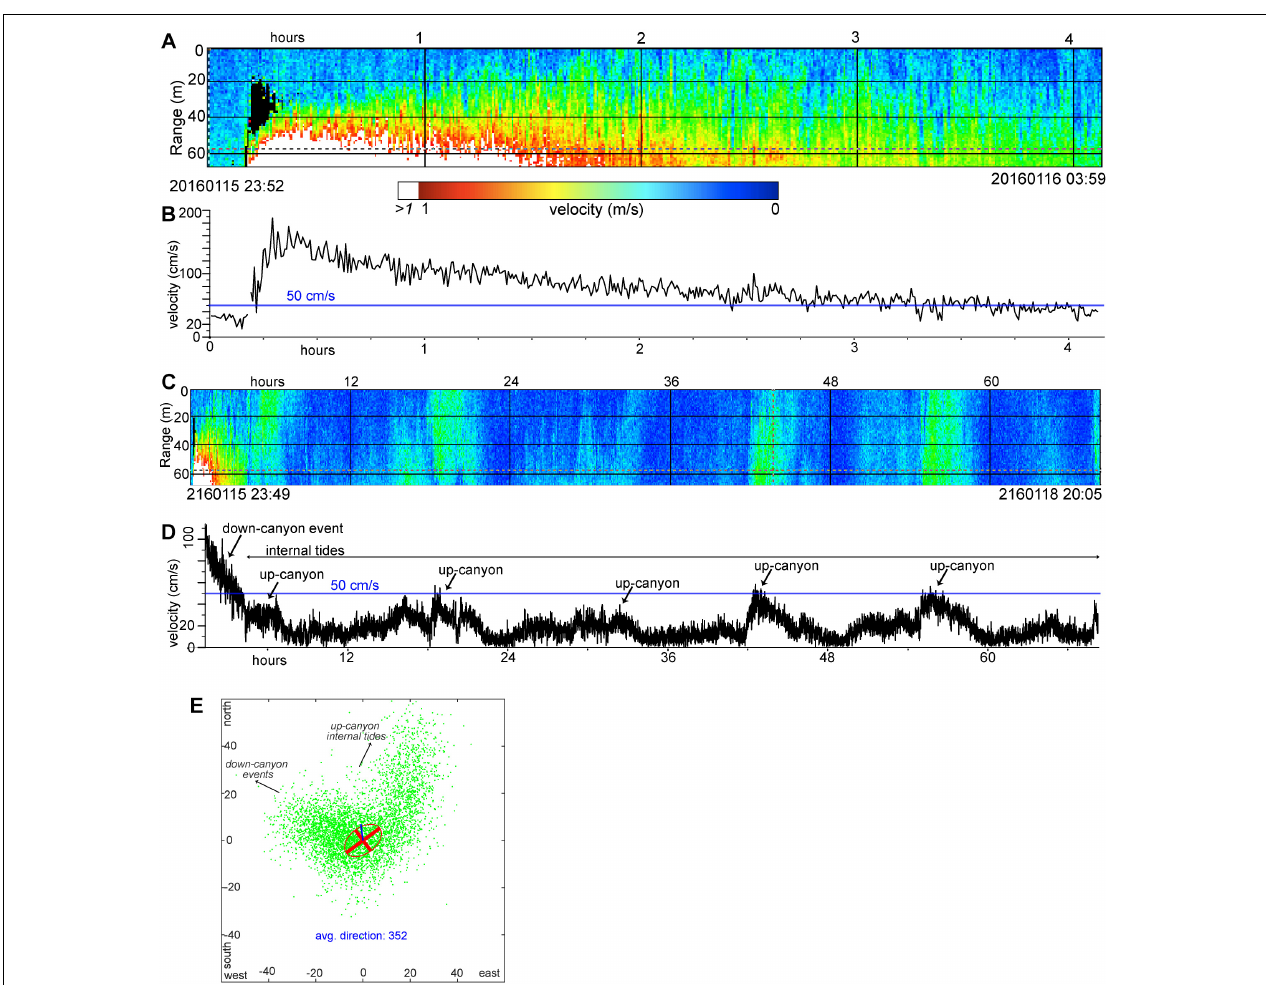
FIGURE 7 | Velocity during and following the January 15, 2016 event measured at MS7. (A) Color-contoured ADCP velocity panel. Range (y-axis) is shown as meters below the ADCP instrument, deployed at 65 m above the seafloor on mooring MS7. When the mooring is upright, the seafloor is at range 65 m, which is the base of this plot. (B) ADCP-measured velocity at approximately 10 m above the seafloor (masf) from (A) . (C) Color-contoured ADCP-measured velocity (labels as in A ), showing post-event internal tide variations. (D) Velocity profile from approximately 10 masf in (C) . (E) Scatter plot of MS7 velocity directions from 15 masf during Deployment I. Down-canyon internal tides and sediment density flow events are oriented primarily to the west-northwest, and up-canyon internal tides oriented primarily to the north-northeast.